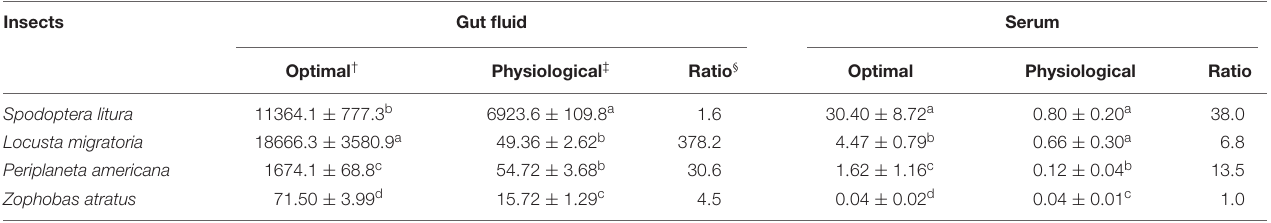
TABLE 3 | Comparison of the optimal and physiological dsRNA nuclease activity in the gut lumen and hemolymph of four insect species (RFU · mg − 1 protein · s − 1 ).